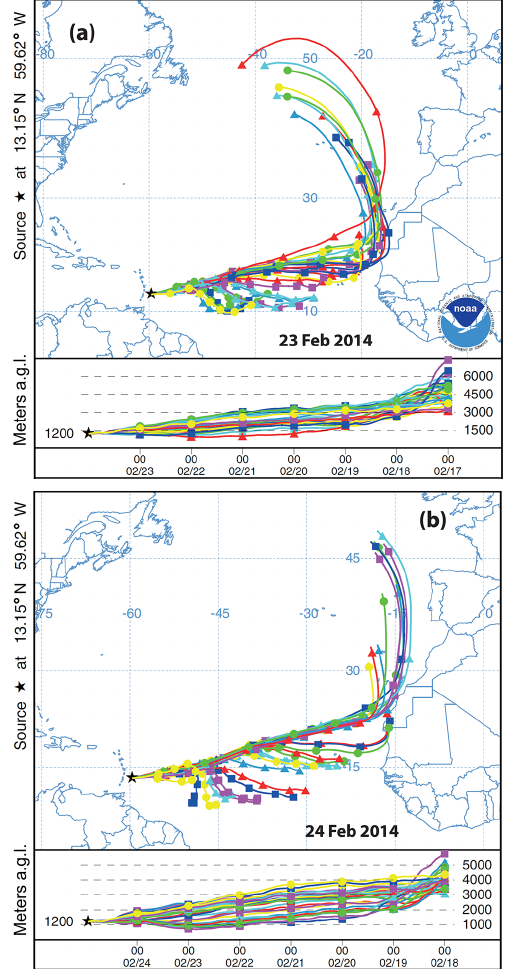
Figure 6. Ensemble of 7-day backward trajectories (HYSPLIT, 2017) for (a) 24 February 2014, 00:00UTC, and (b) for 24 February 2014, 23:00UTC, arriving at 1200m over